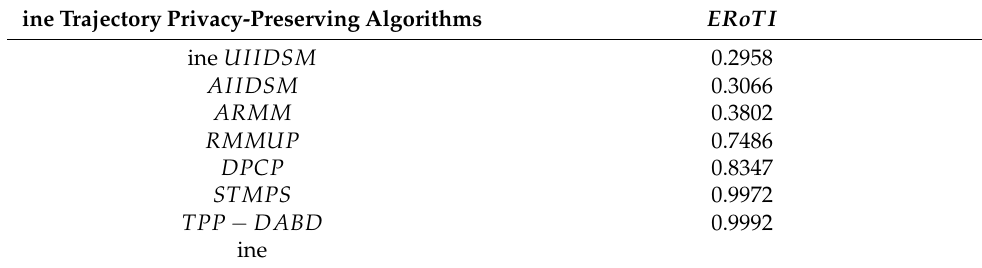
Table 6. The ERoTI of trajectory privacy-preserving